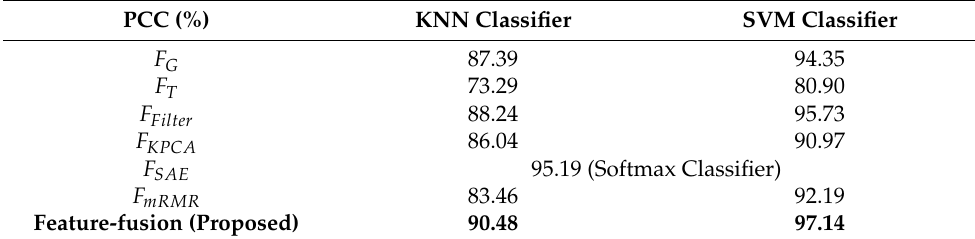
Table 1. The PCC of different feature vectors in different